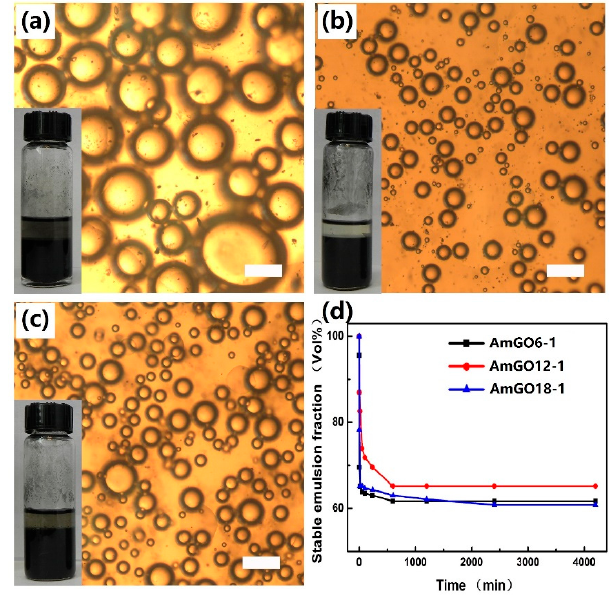
Figure 2. Optical micrographs and photographs 72 h after preparation of water-in-toluene Pickering emulsions stabilized by GO modified with different organic amine: ( a ) AmGO6-1; ( b ) AmGO12-1 and ( c ) AmGO18-1; ( d ) Change in the volume fraction of the residual emulsion as a function of time for the emulsions stabilized by GO modified with different organic amine. Concentration: 1 mg/mL. Toluene/water ratio: 1:1.